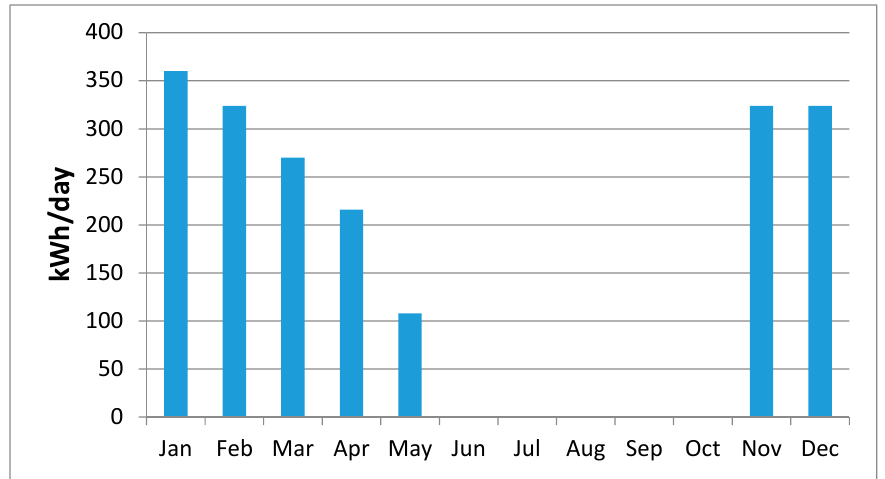
Figure 5. Average monthly irrigation load throughout the year.